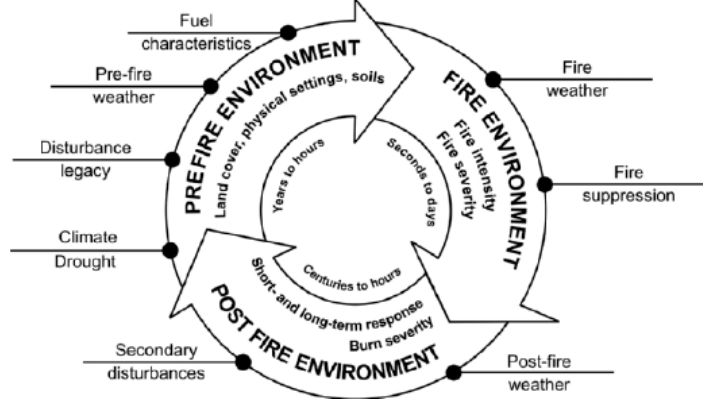
Figure 1. The continuum of wildfire management.